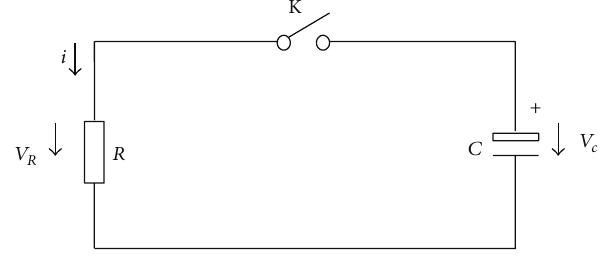
Figure 13: The remaining capacity